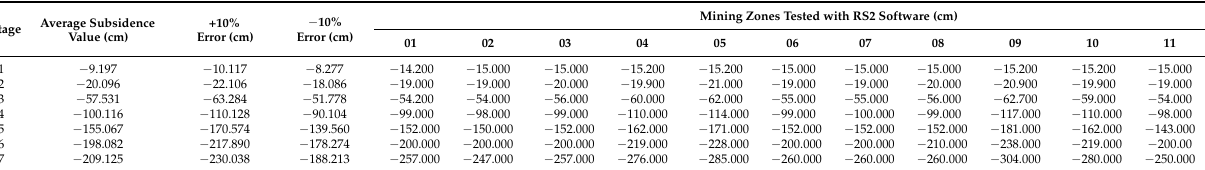
Table 2. Average subsidence values with a 90% confidence level and values of the sections assessed.